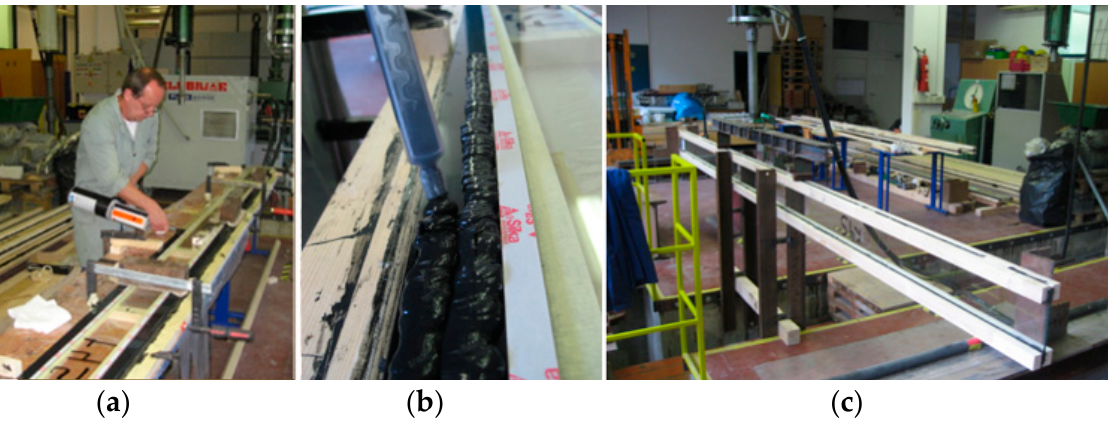
Figure 10. ( a ) application of the silicone between the glass and the timber; ( b ) application of the silicone on the top of the glass; ( c ) final appearance of the timber and glass I-beam. Acrylate